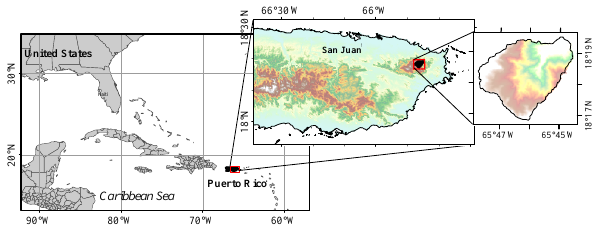
Fig. 1. Puerto Rico is an island of the Caribbean with a roughly rectangular shape. The Mameyes Basin is located in the northeast and on the most elevated areas of the